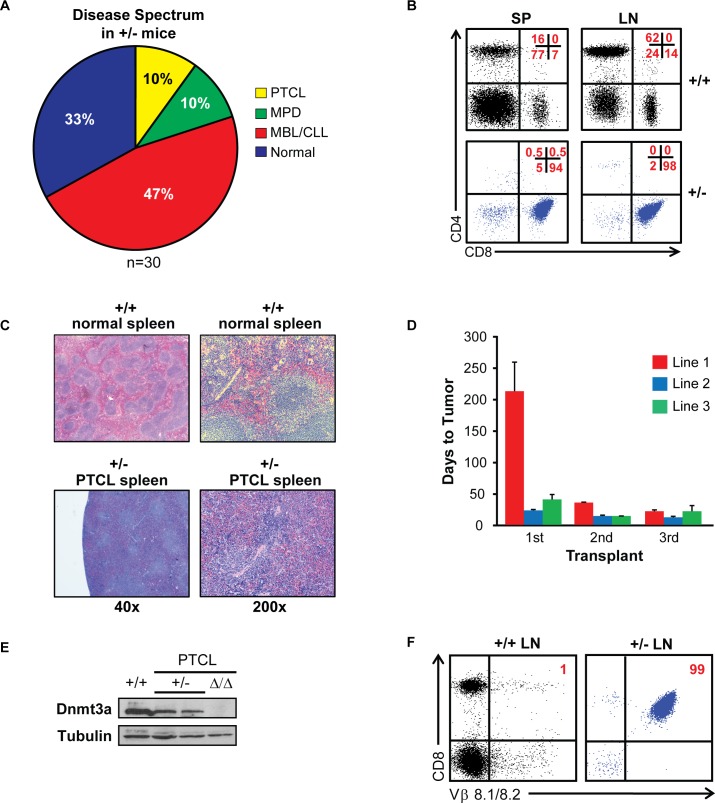
Dnmt3a is a haploinsufficient tumor suppressor in the prevention of CD8+ PTCL in mice.(A) Percentage of conventional heterozygous Dnmt3a+/- mice developing PTCL (yellow), MPD (green), CLL (red), or no disease (blue) at time of harvest, as determined FACS. (N = 30). (B) FACS analysis of CD8 and CD4 expression in cells isolated from the spleens (SP) and lymph nodes (LN) of Dnmt3a+/+ control (+/+) and Dnmt3a+/- PTCL (+/-) mice. Percentages of cells in each quadrant are shown in the top right in red. (C) H&E stained sections of Dnmt3a+/+ (normal) and Dnmt3a+/- (PTCL) spleens (40X and 200X). (D) The time to tumor development for primary (1), secondary (2) and tertiary (3) sub-lethally irradiated FVB-recipient mice serially transplanted with CD8+ PTCL tumors isolated from the lymph nodes of a Dnmt3a+/- terminally sick mice. Data are presented as average time to tumor development. Three PTCL lines are shown. (E) Immunoblot showing Dnmt3a protein levels in Dnmt3a+/+ controls (+/+) and Dnmt3a+/- PTCL (+/-) samples. Dnmt3aΔ/Δ PTCL (Δ/Δ) is shown as a negative control. γ-tubulin is shown as a loading control. (F) Representative flow diagram showing CD8 and TCR-Vβ 8.1/8.2 expression in Dnmt3a+/+ controls (+/+) and Dnmt3a+/- PTCL LN samples.